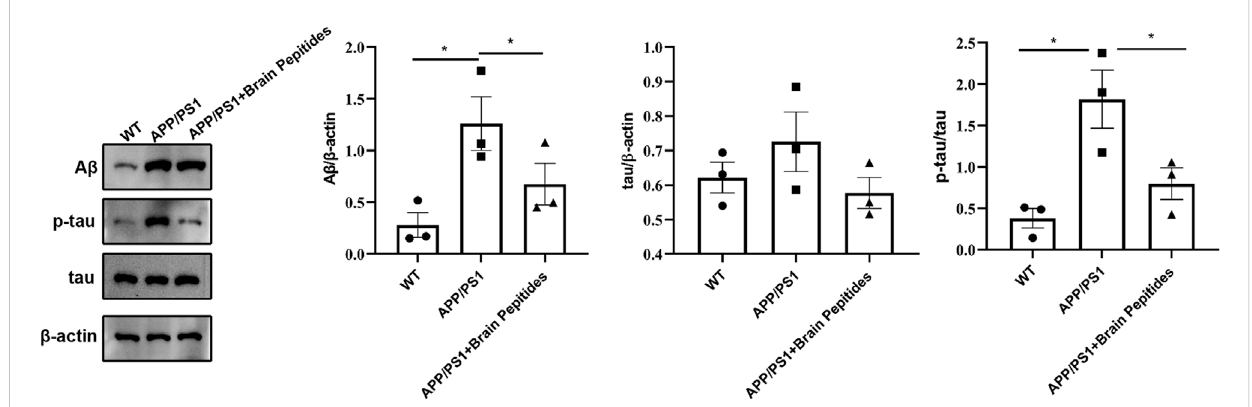
CerebroproteinhydrolysateimprovestheexpressionofA β ,tauandp-tauinthehippocampusofAPP/PS1mice;(n=3).Note:Thedataareexpressed as the mean ± standard error mean ( (cid:1) x ± sem), as revealed by the one-way analysis of variance. * p < 0.05, ** p < 0.01.